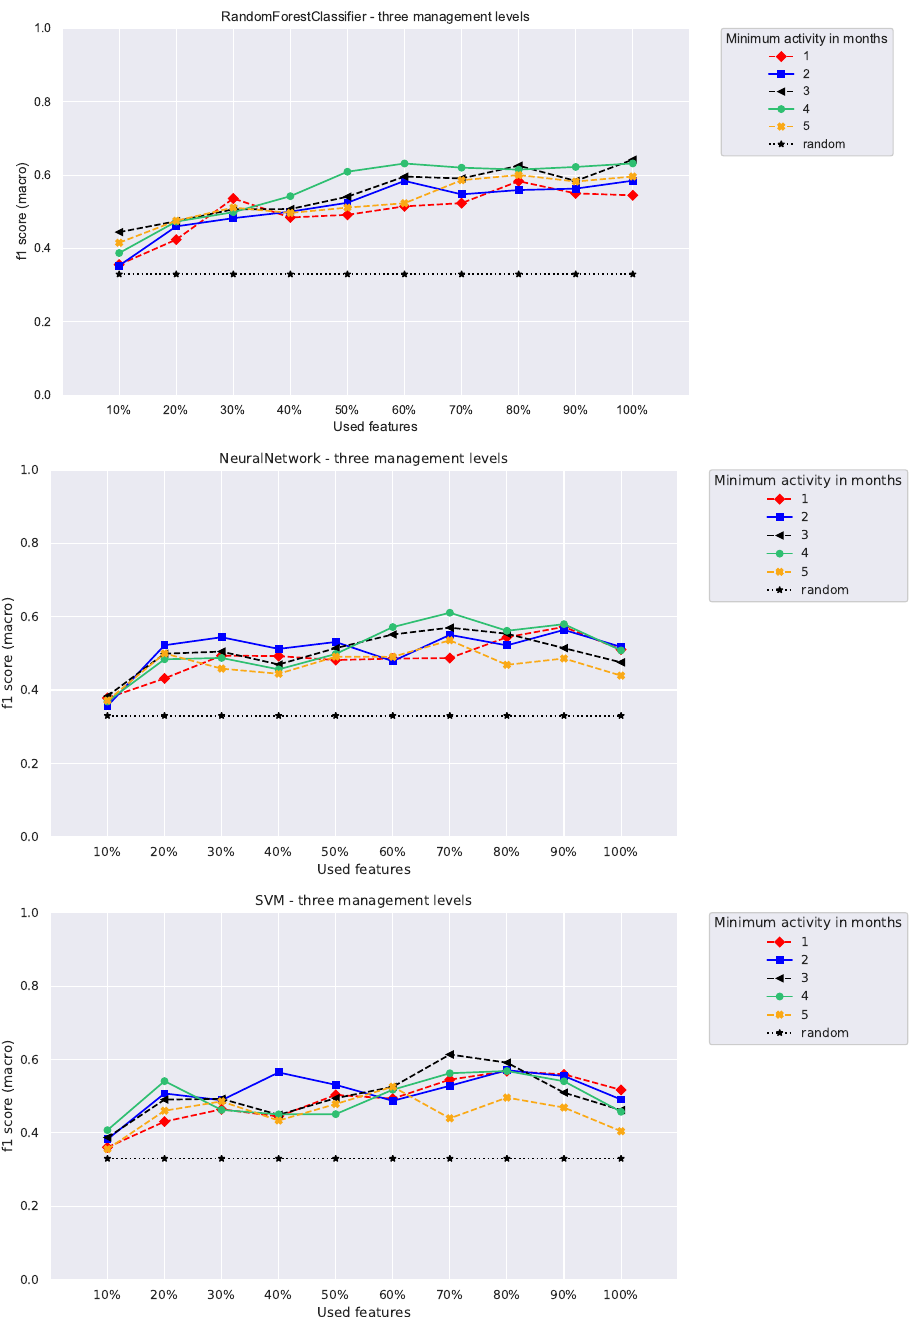
Figure 7. The result of the classification of three groups for the Enron company